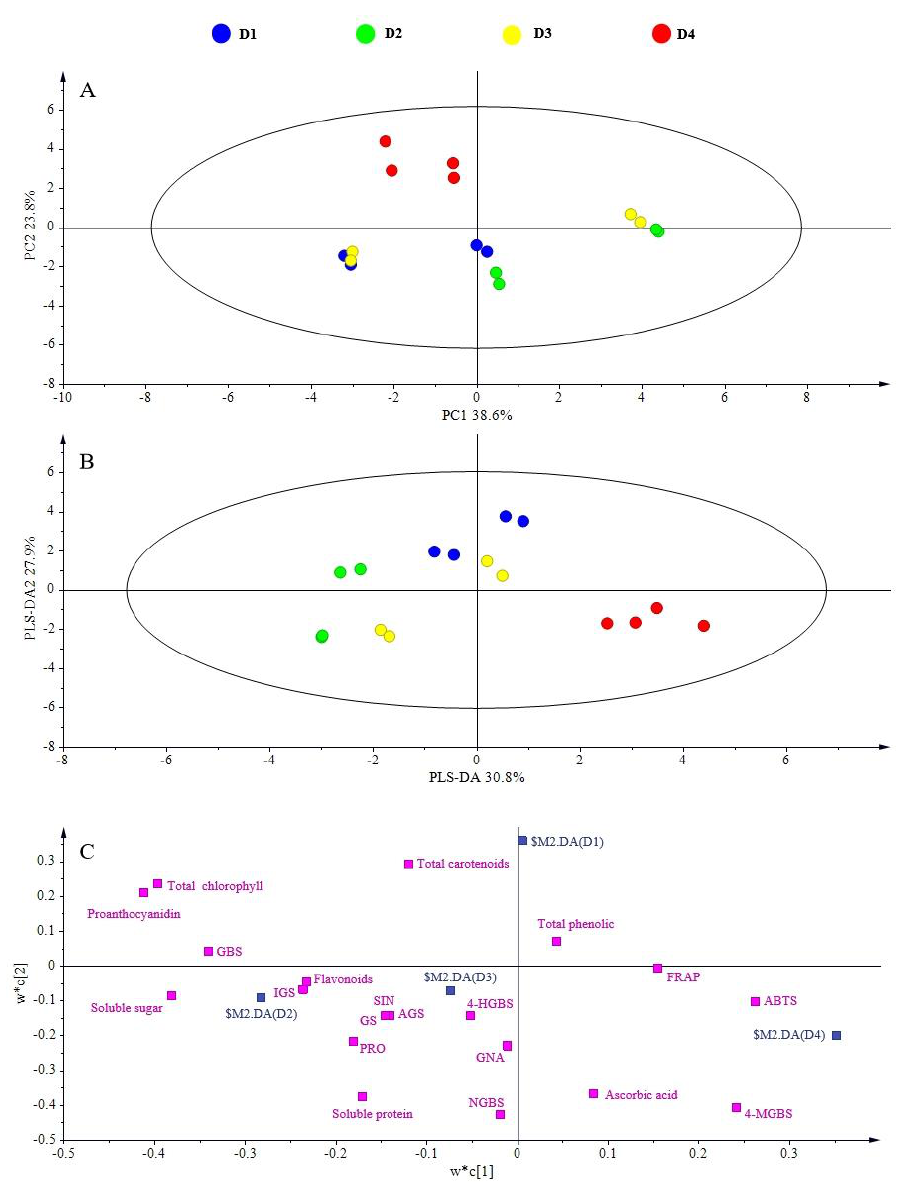
Figure 3. PCA analysis of different dark treatments on mustard sprouts. ( A ) PCA score plot; ( B ) PLS-DA score plot; ( C ) loading plot. SIN: sinigrin; GNA: gluconapin; PRO: progoitrin; NGBS: neogluco- brassicin; GBS: glucobrassicin; 4-MGBS: 4-methoxyglucobrassicin; 4-HGBS: 4-hydroxyglucobrassicin; AGS: total aliphatic glucosinolates; IGS: total indolic glucosinolates; GS: total glucosinolates. D1: dark treatment for one day; D2: dark treatment for two days; D3: dark treatment for three days; D4: dark treatment for four